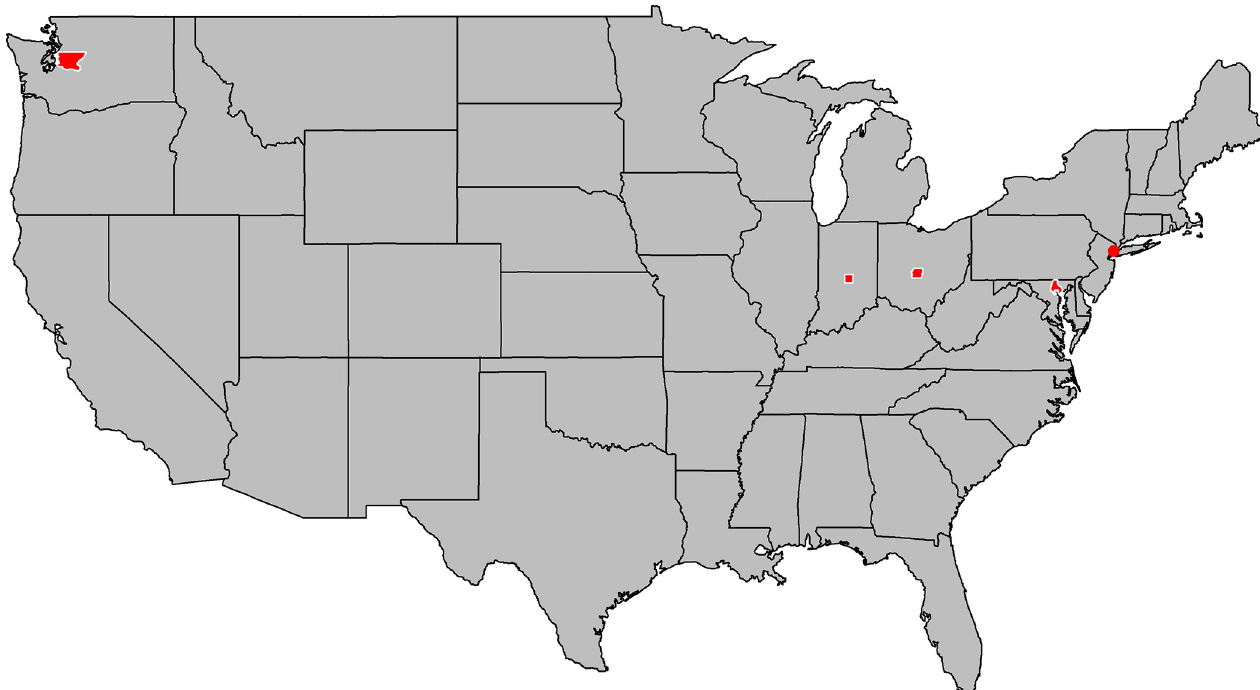
Fig 1. Study sites selected for analysis. Study sites are marked red. From left to right: KCW: King County, Washington (including Seattle); MCI: Marion County, Indiana (including Indianapolis); Franklin County, Ohio (including Columbus); BCM: Baltimore County, Maryland (including Baltimore); NYC: New York